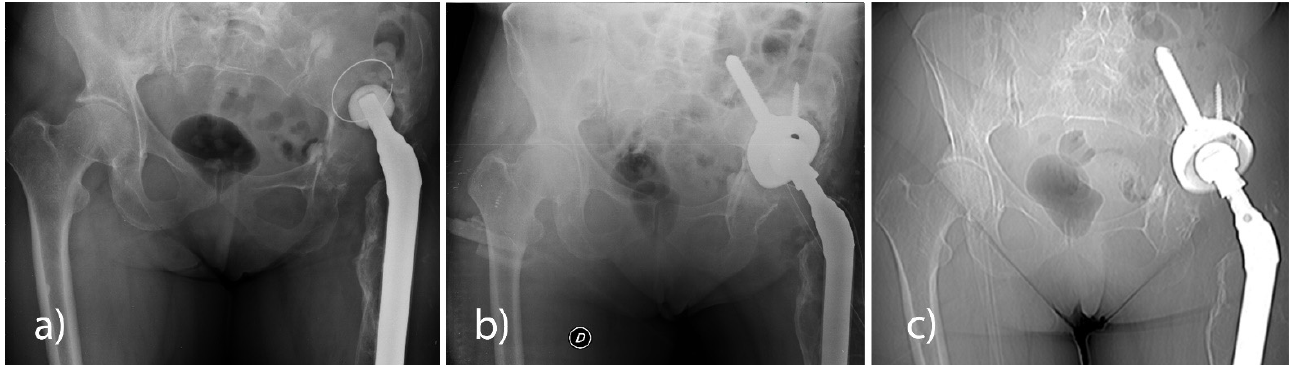
Figure 1. ( a ) Aseptic mobilization of the right hip prosthesis cup. ( b ) 6-month post-operative radiographic control shows the revised cup (Sansone cup with an iliac stem and RegenOss) stably in place. ( c ) A 12-month CT scan shows no signs of prosthetic loosening.